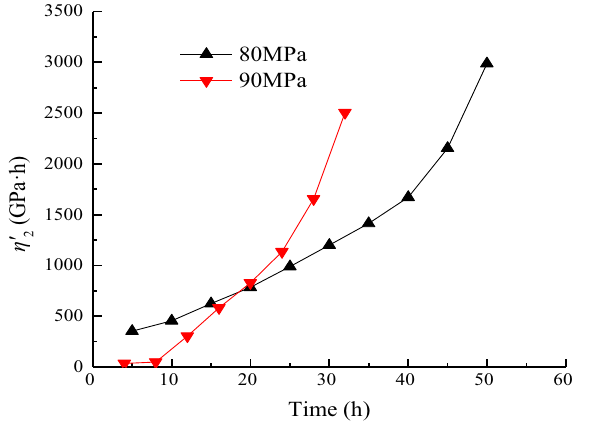
Figure 16. Duration of η ’ 2 when σ 3 = 15 MPa.